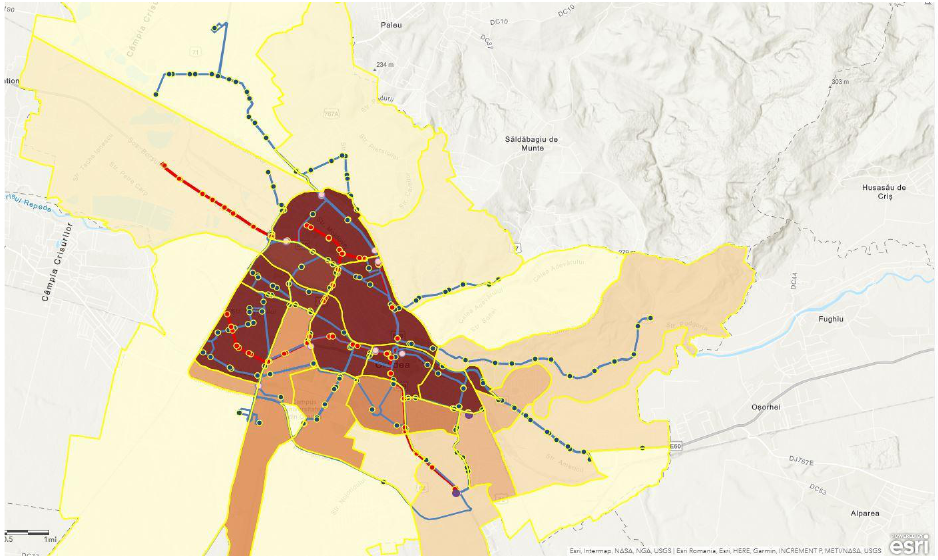
Figure 8. Density of tram/bus stops per each neighborhood. (Realized by the authors in ArcGIS Online).